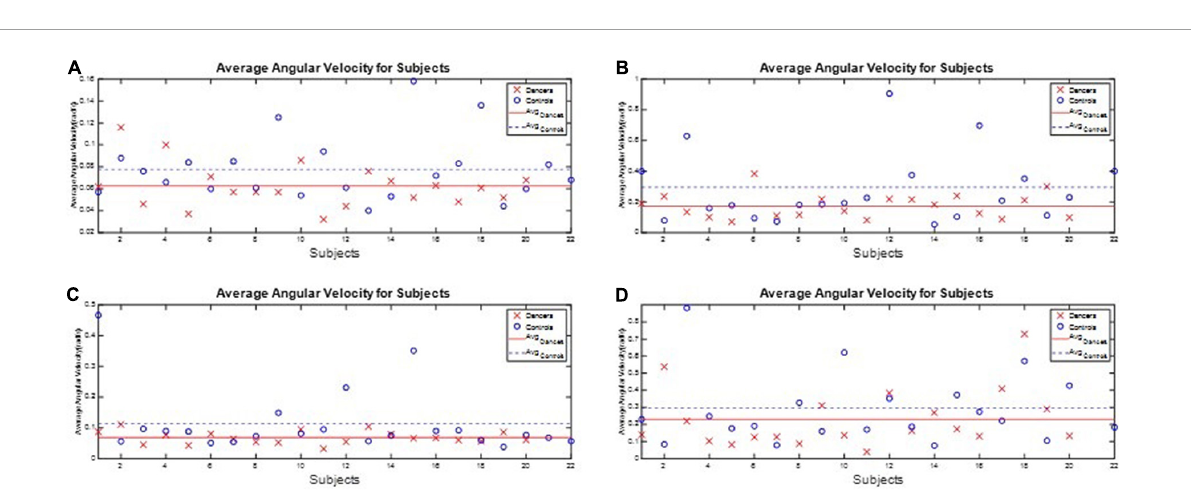
FIGURE10 The performance index J 3 during the one-leg stance tests. The dancers’ angular velocity index J 3 were about 80.68, 58.52, 60.66, and 77.34%, respectively, of those of the healthy controls during the four actions. (A) Standing on the dominant foot with eyes open. (B) Standing on the dominant foot with eyes closed. (C) Standing on the non-dominant foot with eyes open. (D) Standing on the non-dominant foot with eyes